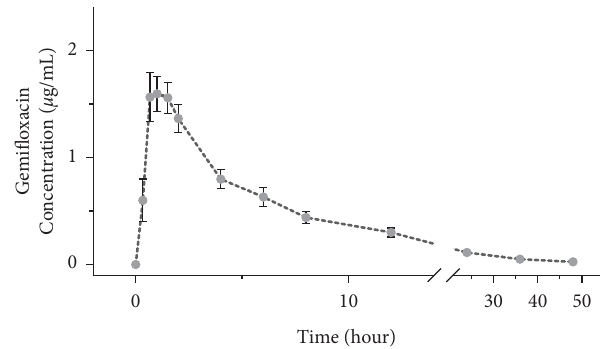
Figure 4: Mean ( ± standard error) plasma concentration–time profles of gemifoxacin that were derived based on the samples that were obtained from 13 participants after the administration of a single oral dose of 320mg